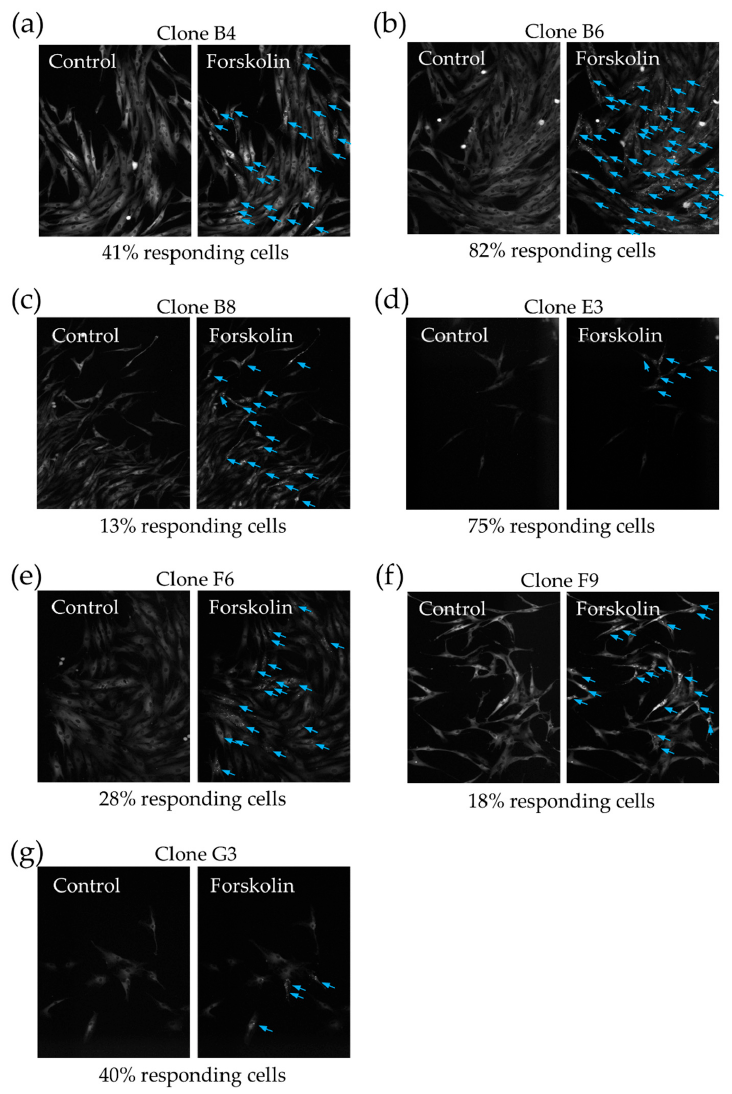
Figure 4. Responses on the forskolin adding to single cell-derived clones of MSC expressing PKA-Spark. Blue arrows mark responding cells. Scale bar 100 µ m. ( a – g ) representative images of responses of 7 distinct MSC clones. The ratio of responding cells indicated on each panel.